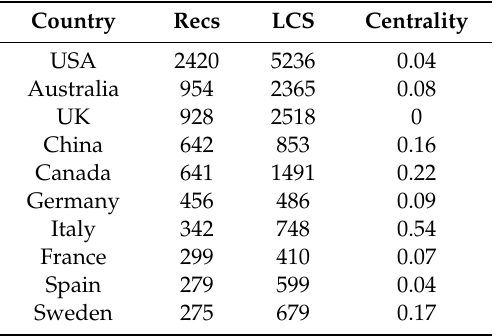
Table 2. List of the top 10 countries and regions, with numbers of published articles. Country Recs LCS Centrality USA 2420 5236